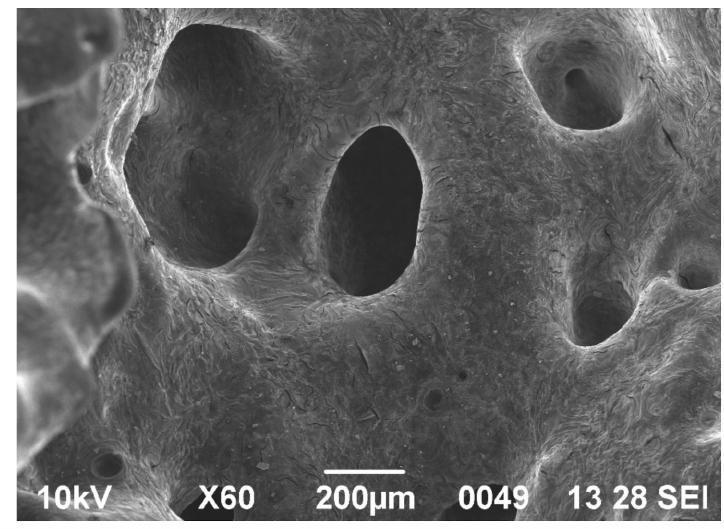
Figure 6. SEM of carbon foam.